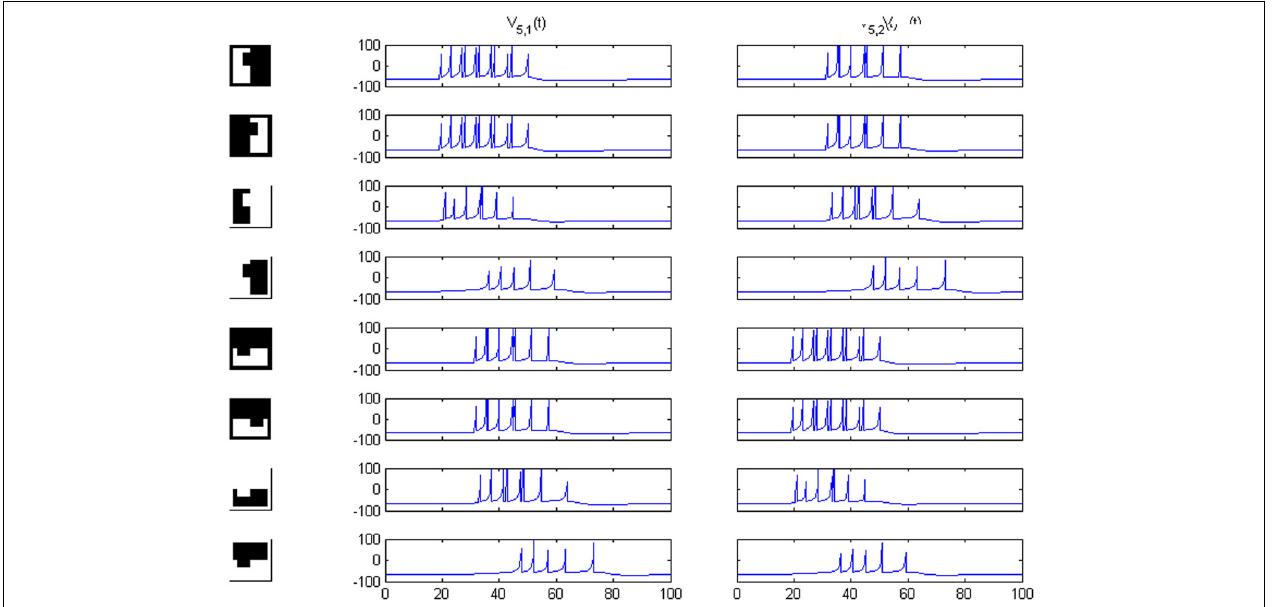
FIGURE 8 | Potentials on area 5 for the first image set of Figure 2 and its own rotated version. Cell 1 and cell 2 responses are interchanged.